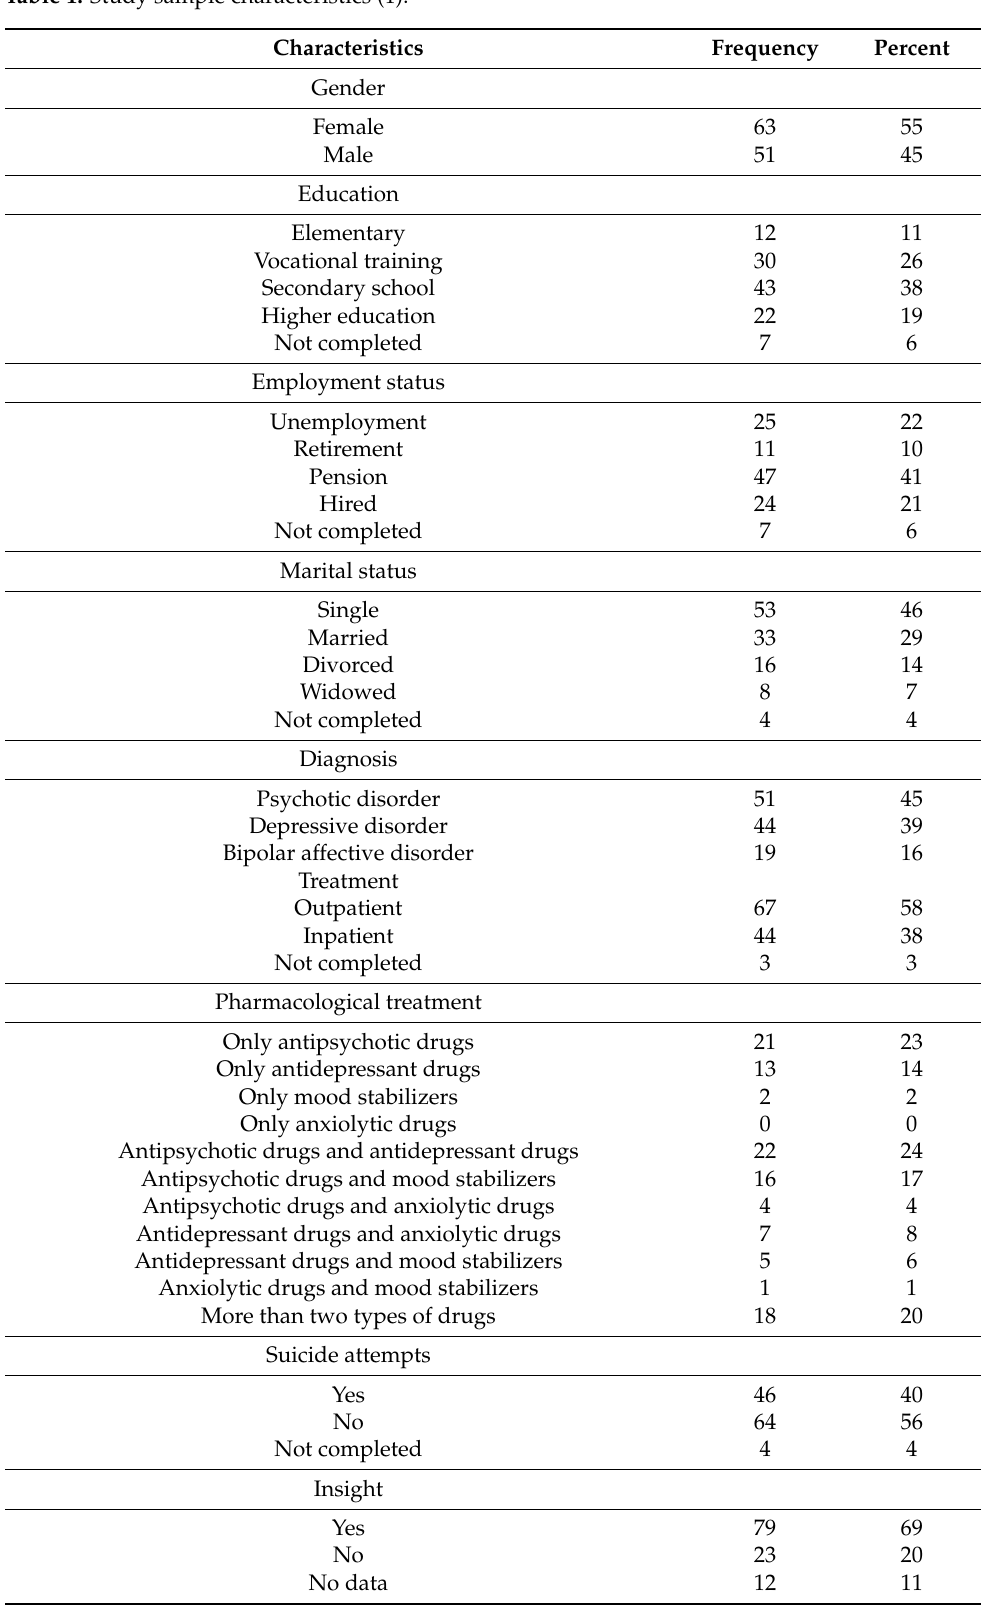
Table 1. Study sample characteristics